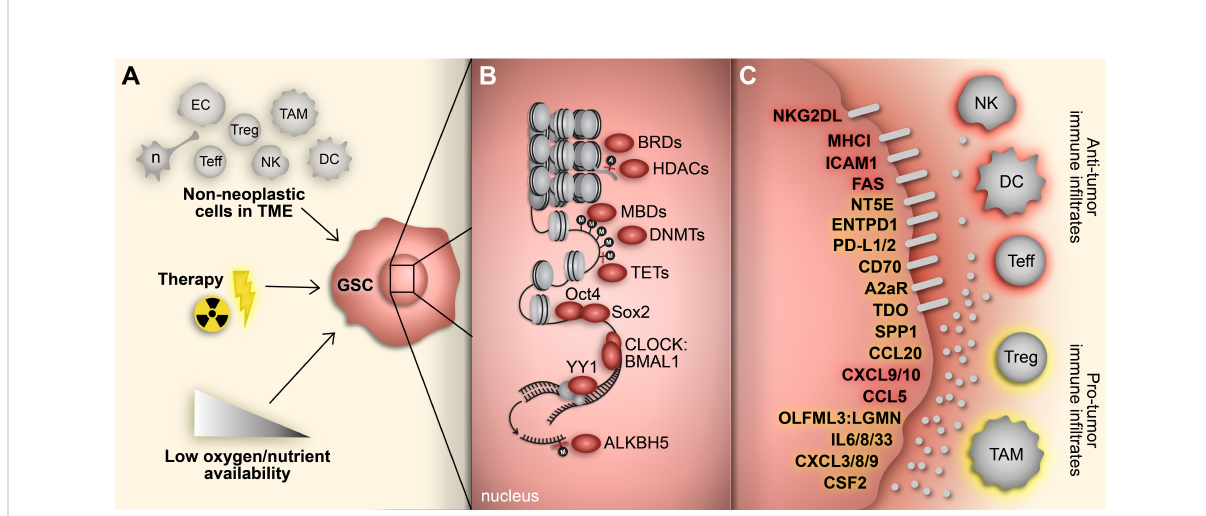
(B) These extrinsic stimuli induce reprogramming events, including acquisition of a stem-like state in GBM cells. Transition to a GSC state results from altered gene expression mediated by various transcriptional regulators (e.g., epigenetic modi fi ers, transcription factors) that regulate immunomodulatory mechanisms. (C) GSC-intrinsic immunomodulatory mechanisms occur through induction (yellow) or repression (red) of immune-related genes that play a key role in shaping the TIME in GBM. Cell types: EC, endothelial cell; n, neuron; Teff, effector T cell; Treg, regulatory T cell; NK; natural killer cell; TAM, tumor-associated macrophage/microglia; DC, dendritic